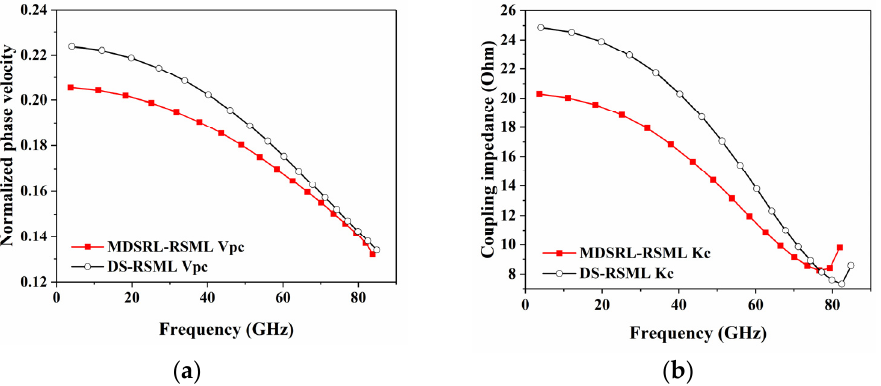
Figure 5. Comparison of ( a ) dispersion and ( b ) coupling impedance characteristics between DS-RSML and MDSRL–RSML SWS.